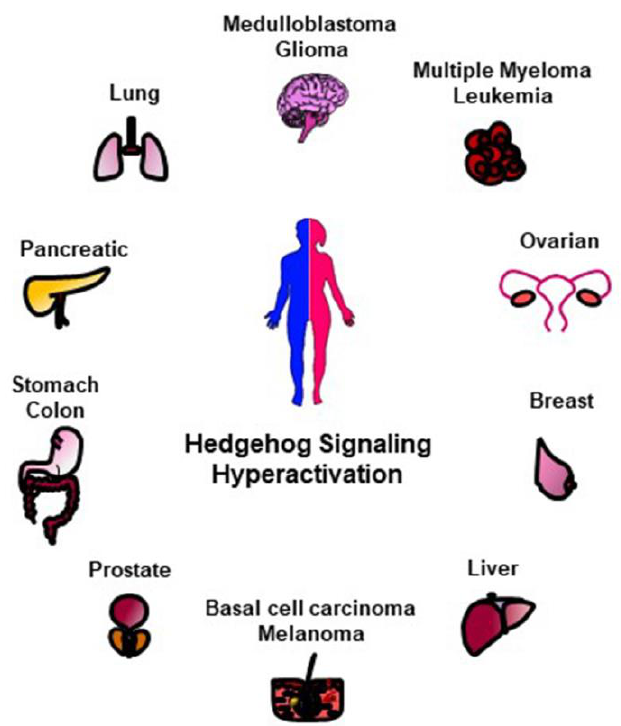
Figure 2. Schematic representation of HH-related tumors. The hyperactivation of HH signaling is involved in the tumorigenesis of several human malignancies here reported.